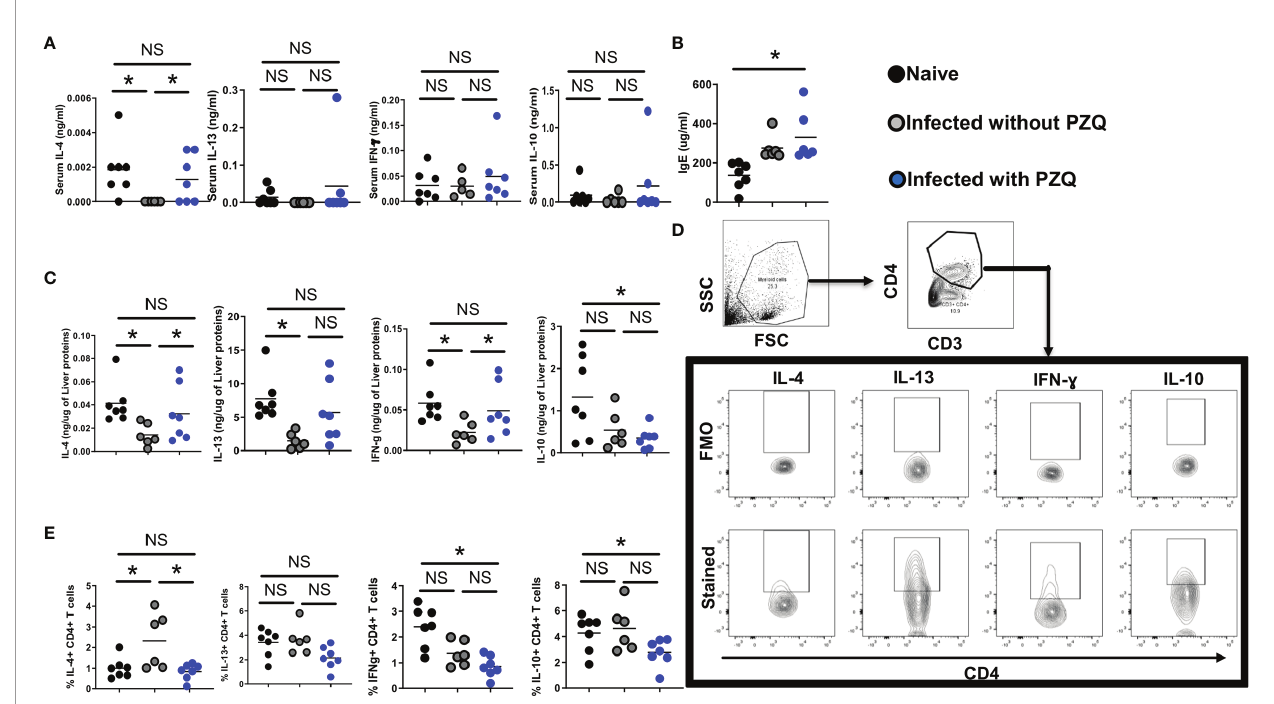
FIGURE 6 | Impact of infection and Infection-PZQ treatment combo on host immune response. Outcome measure = Change in immune markers in animals. (A) Serum total cytokine levels (B) and total IgE levels were determined by ELISA in ng/ml and ug/ml respectively. (C) Liver lobes collected from animals treated according to the differential scheme and sacri fi ced at week 16 were homogenized and the production of cytokines (IL-4, IL13, IFN-g and IL-10) was determined as a function of the protein amount of liver tissue probed. Liver lobes were processed for FACS analysis and the gating of cells and cytokine-producing CD4+ T cells de fi ned as shown in (D) . (E) Summary frequencies of cytokine-producing hepatic CD4+ T cells. Experiments were conducted in two independent runs with 5-7 mice per group. Data are expressed as mean ± SEM; NS = p > 0.05; *= p < 0.05 as determined by Kruskal-Wallis test with correction for multiple comparisons by Dunn ’ s